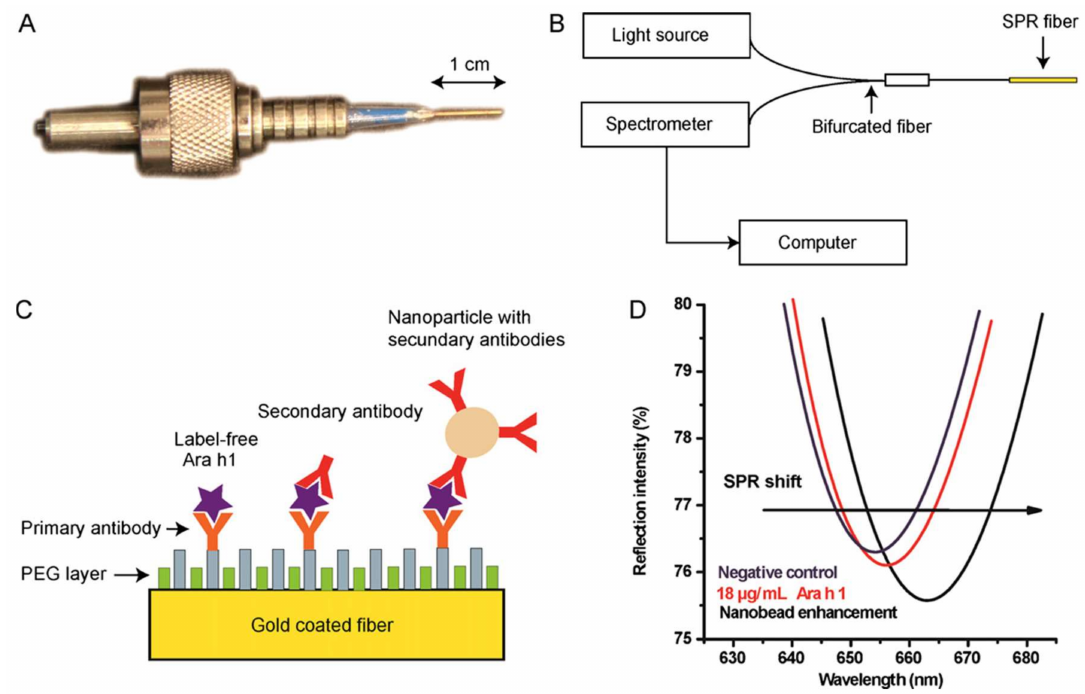
Figure 8. ( A ) Fibre optic surface plasmon resonance (SPR) probe; ( B ) system setup scheme; ( C ) Ara h 1 immunoassay detection strategies on the fibre optic SPR biosensor; ( D ) the spectrum dips in PBS buffer after 10 min incubation of the SPR fibre in: a negative control sample (blue dip), a sample containing 18 µ g/mL Ara h 1 (red dip), a sample containing 18 µ g/mL Ara h 1 subsequently labelled with antibody linked nanobeads (black dip). Reprinted with permission from [65]. Copyright 2018